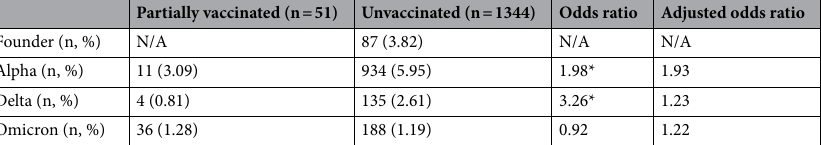
Table 10. Comparison of mortality rate and mortality odds ratio by variants between partially vaccinated and unvaccinated individuals. p -value < 0.05 is significant, *denotes p -value < 0.05.